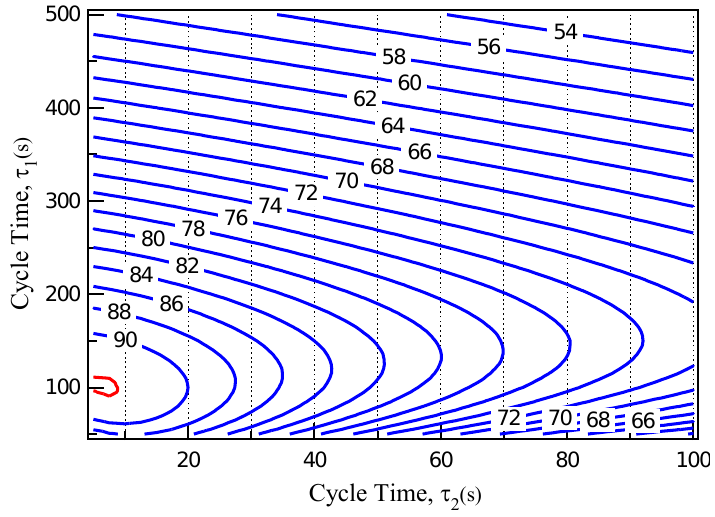
Figure 8. Contour plot of SCP relating to processing time τ temperature of proposed system.